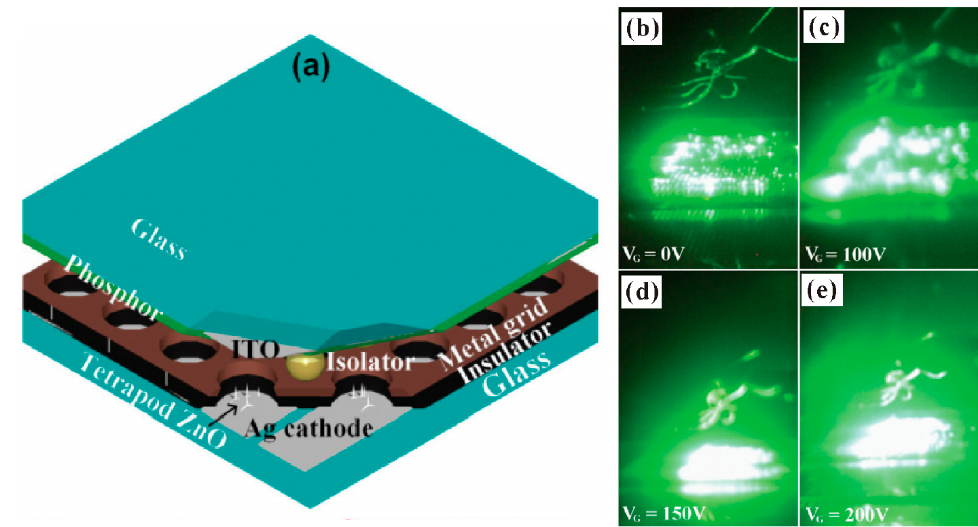
Figure 32. Demonstration of a field-emission light source based on ZnO nanostructures. ( a ) Schematic diagram of the device. ( b – e ) Field-emission images for gate voltage of 0, 100, 150 and 200 V. Reproduced from [106], with the permission of RSC Pub, 2014.